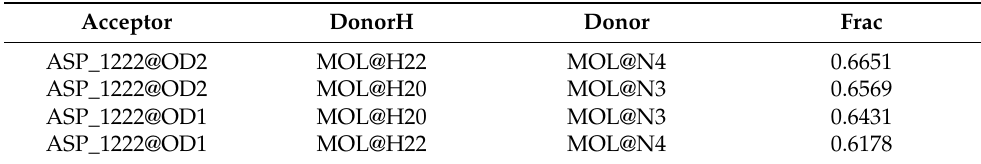
Table 6. Hydrogen bond distribution for the